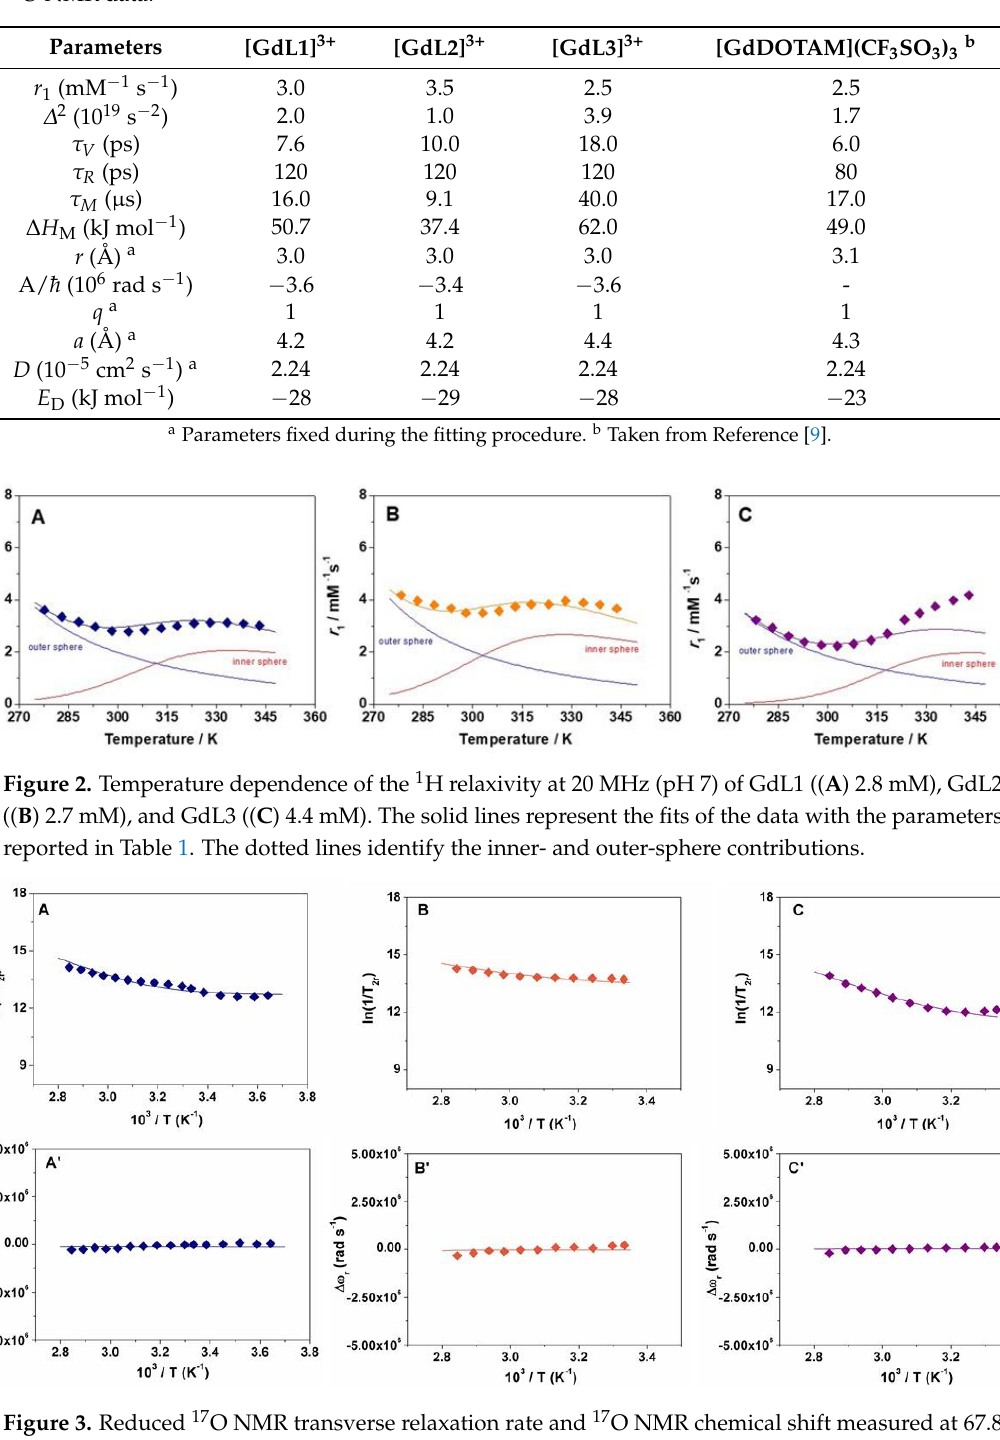
Table 1. Best-fit parameters obtained from the analysis of the 1 H NMRD profiles (298 K), 1 H-VT and 17 O NMR data.